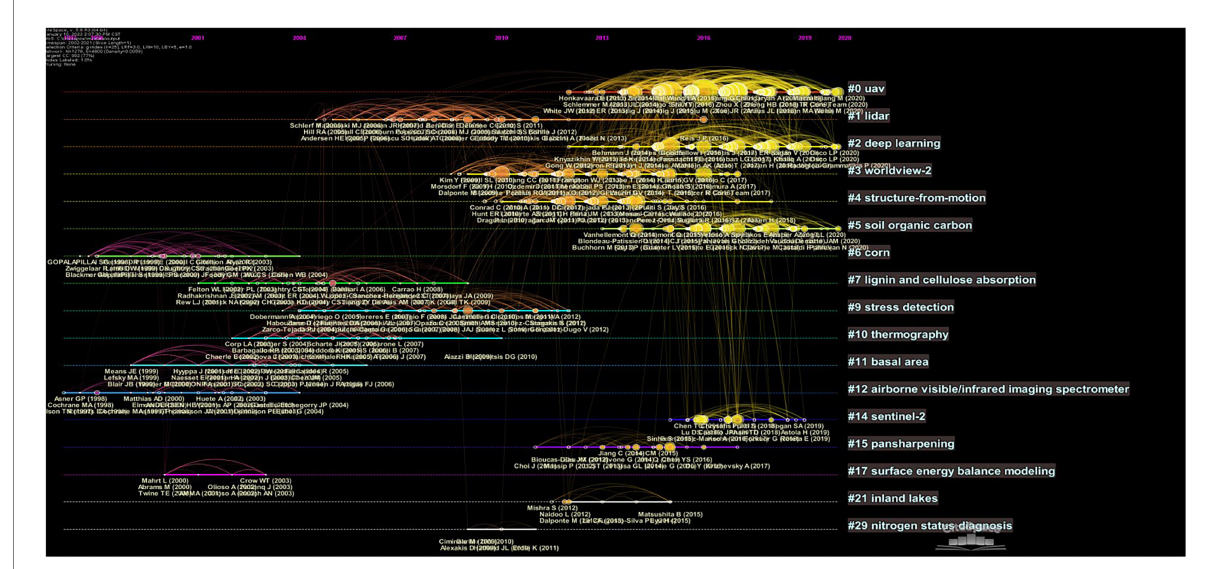
FIGURE 8 Co-citation timeline mapping of publications on agricultural multispectral research in 2002–2021. The horizontal axis represents the year, each node represents a popular cited reference, and the size of each node is proportional to its citation frequency. The line between each node represents the time evolution of the cited literature, and the thickness of the line represents the co-citation